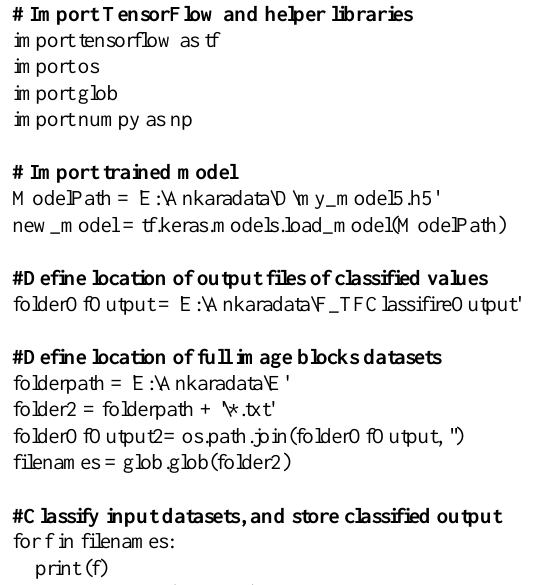
Table 3 Step F, image datasets classification in Anaconda environment using the TF developed